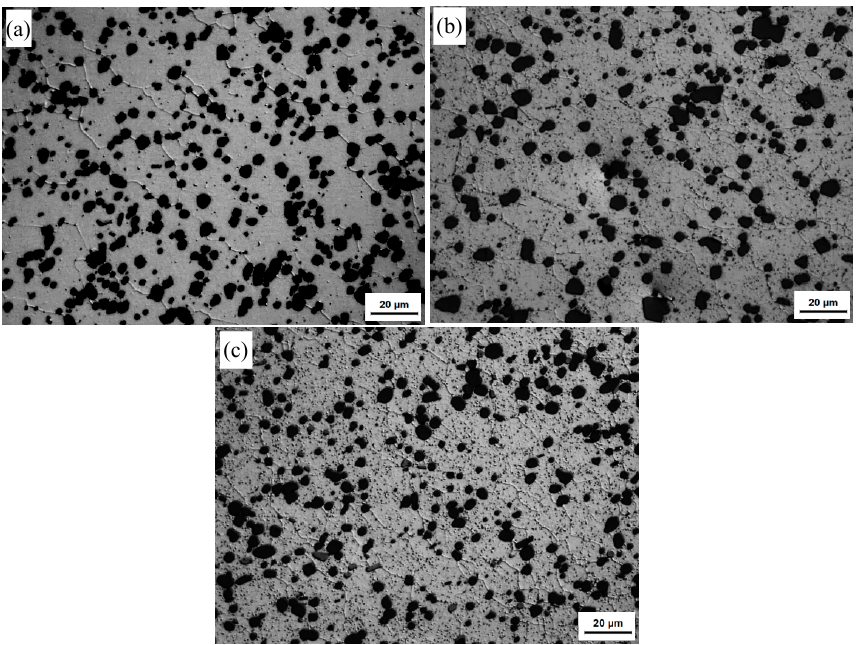
Figure 10. Optical microstructures at the heat affected zones (HAZs) of FSW joints under different states: ( a ) T1; ( b ) T4; ( c ) T6.